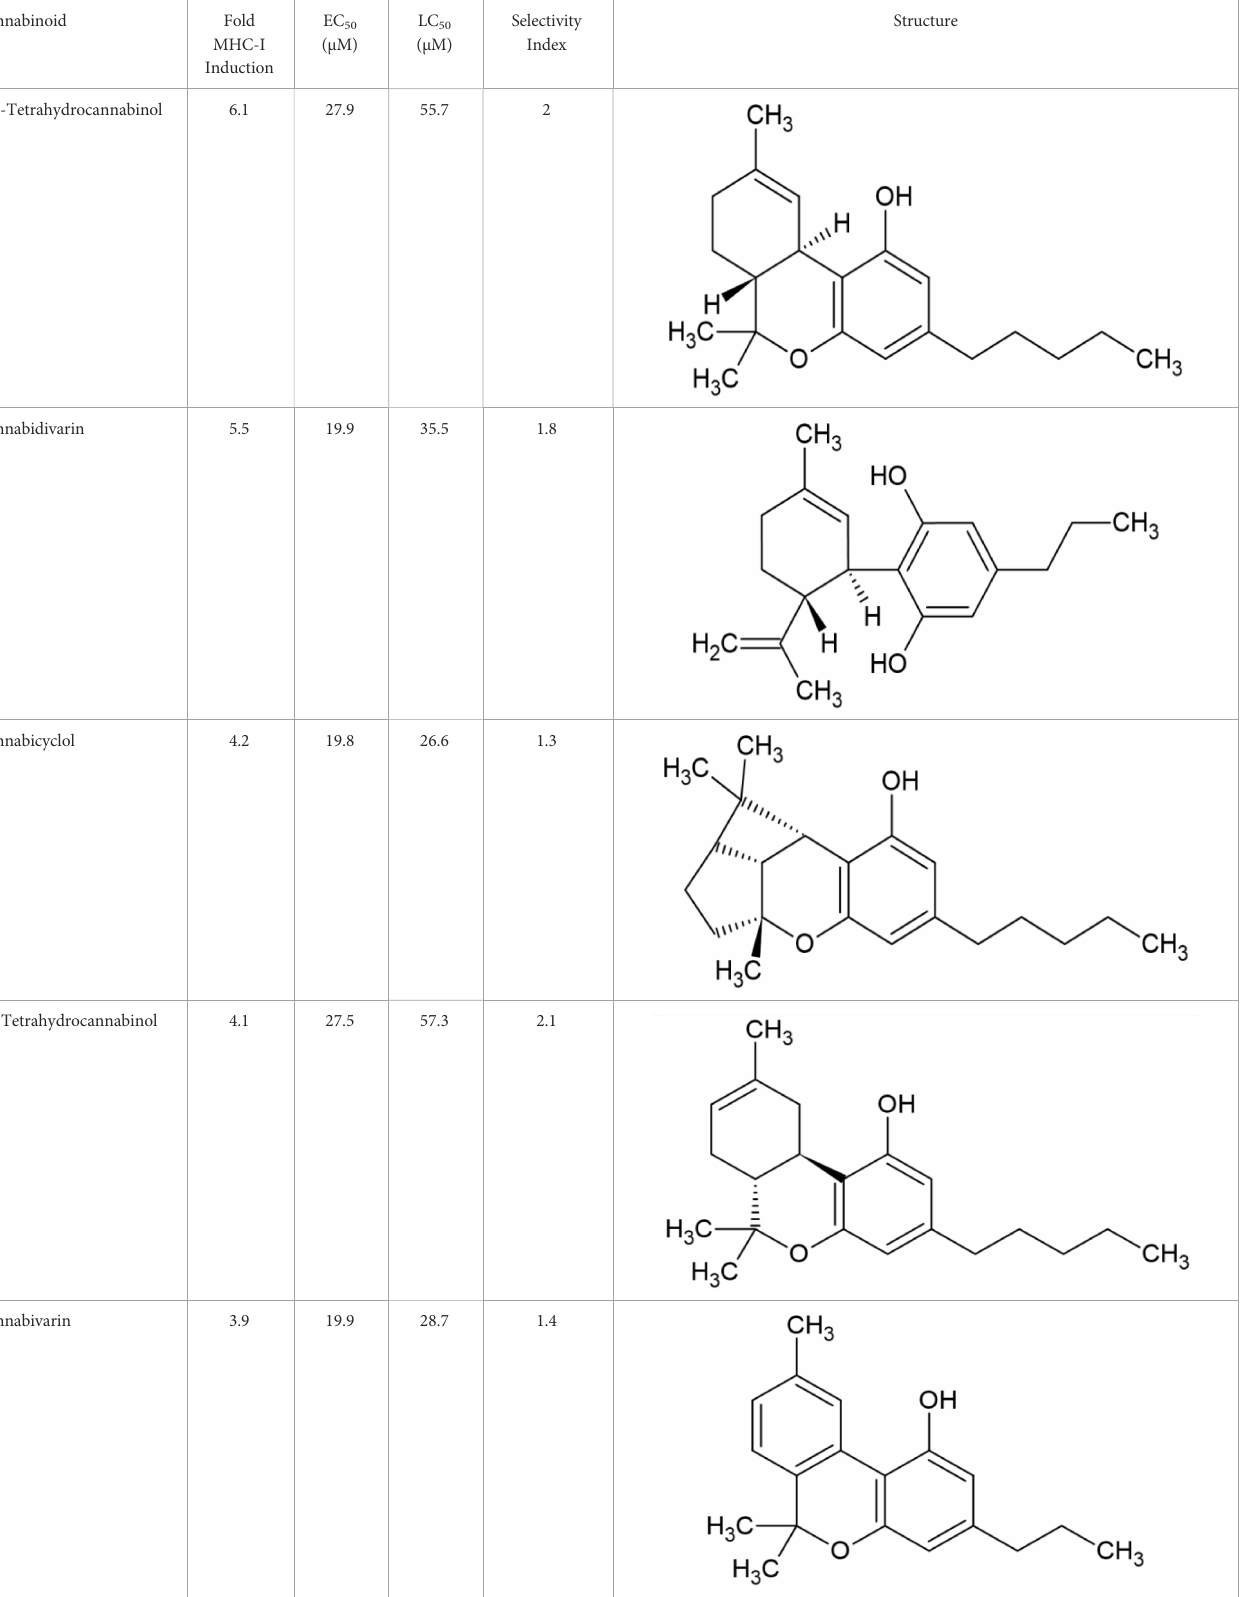
TABLE 2 MHC-1 induction in COLO-205 cells by phytocannabinoids.